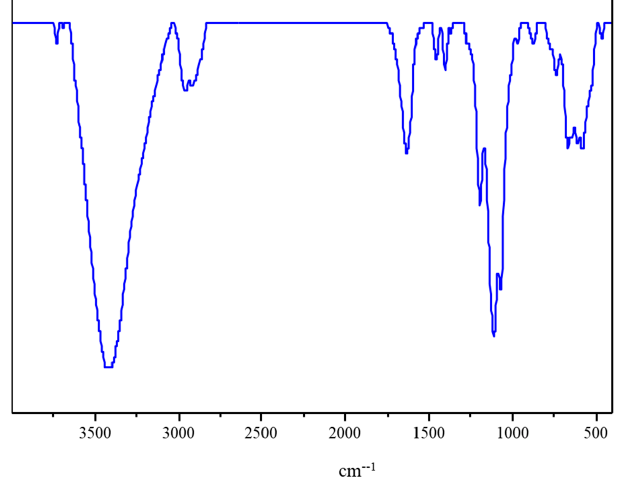
Polymers 2023 , 15 , x FOR PEER REVIEW Figure A1. FTIR spectrum of HPCP. Figure A1. FTIR spectrum of HPCP.